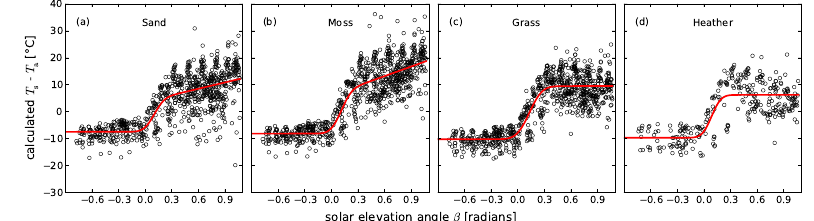
Figure 8. Measured surface temperature relative to air temperature ( T s – T a ) for clear hours ( f cd > 0.9) as a function of solar elevation angle β . Relationships (red lines) were fitted to the data using Eq. (6).